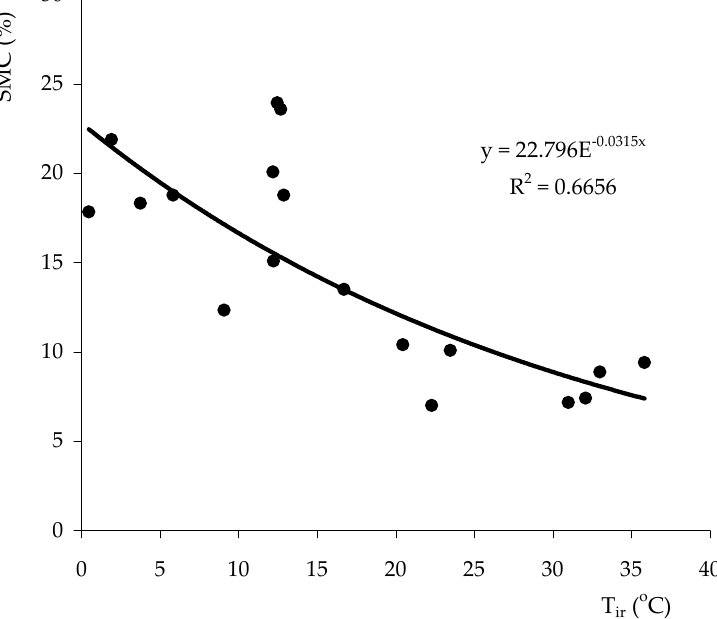
Figure 4. Relationship between pasture surface temperature (T ir ) and soil moisture content (SMC) over sampling times (between January 2017 and June 2018). Data are average values of 12 sampling points.